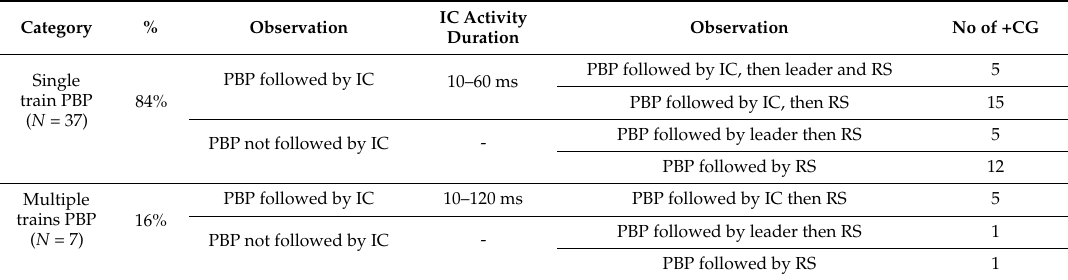
Table 2. Classification of PBP based on the number of trains preceding the first